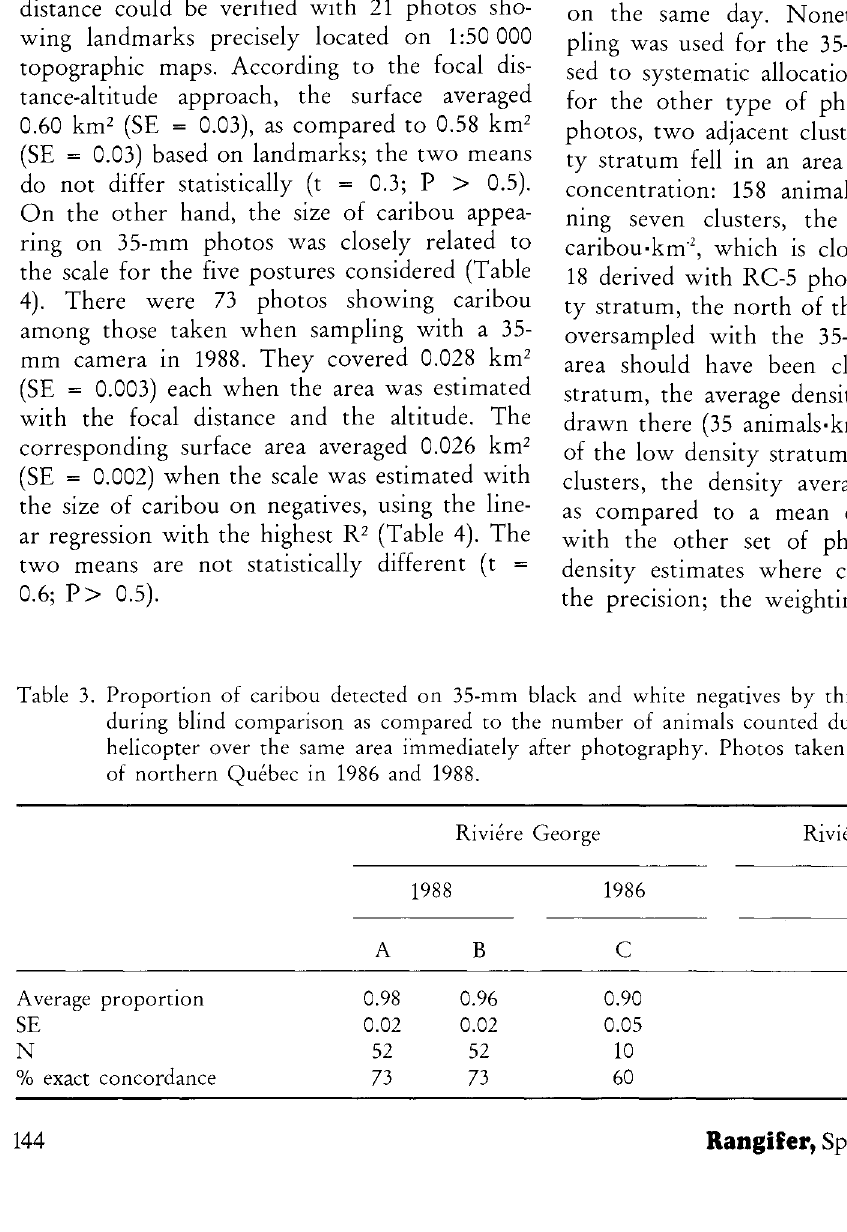
Table 3. Proportion of caribou detected on 35-mm black and white negatives by three observers (A, B, C) during blind comparison as compared to the number of animals counted during low level flight in helicopter over the same area immediately after photography. Photos taken over two calving areas of northern Quebec in 1986 and